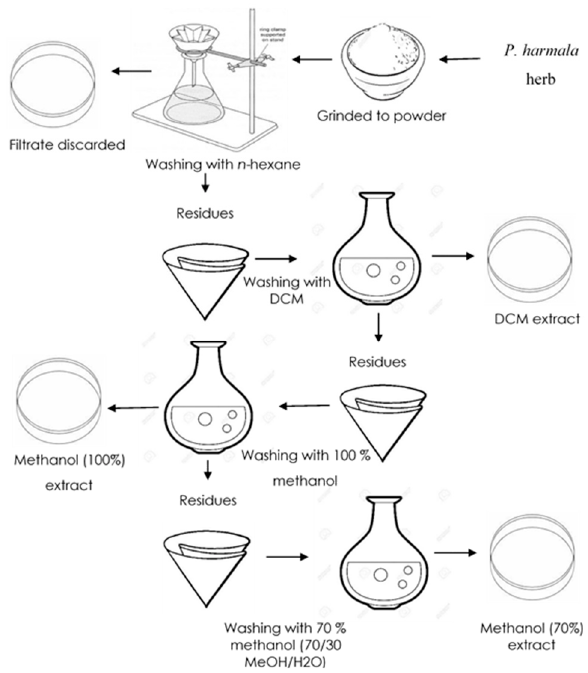
Figure 2. Sequential extraction of P. harmala powered using various solvents.